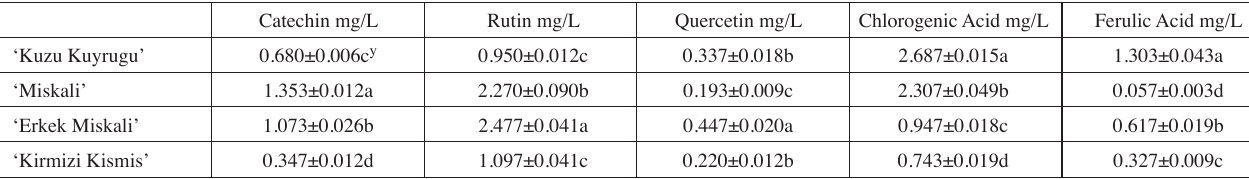
Tab. 3: Phenolic compounds in berries of the grape